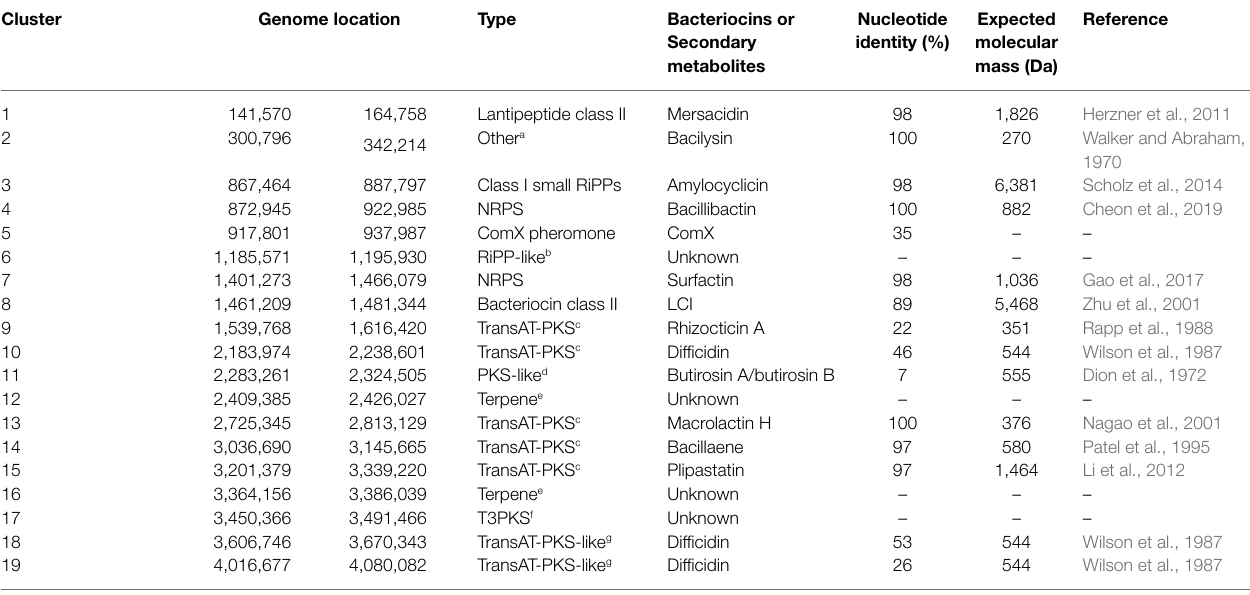
TABLE 3 | Identification of gene clusters involved in the ribosomally synthesized bacteriocins and secondary metabolite synthesis by B. velezensis ML122-2 using BAGEL4 (clusters 1, 3, 5, and 8) and antiSMASH (remainder of presented clusters).